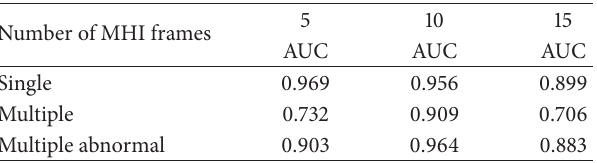
Table 6: Area under curve (AUC) of all classes on our testing data set.